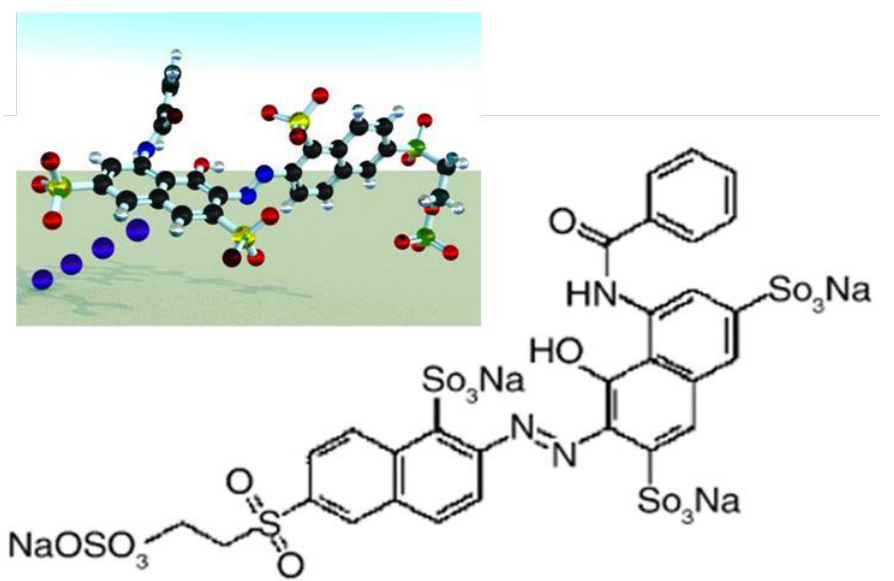
Figure 1. Remazol Brilliant Red F3B (Reactive Red 180).